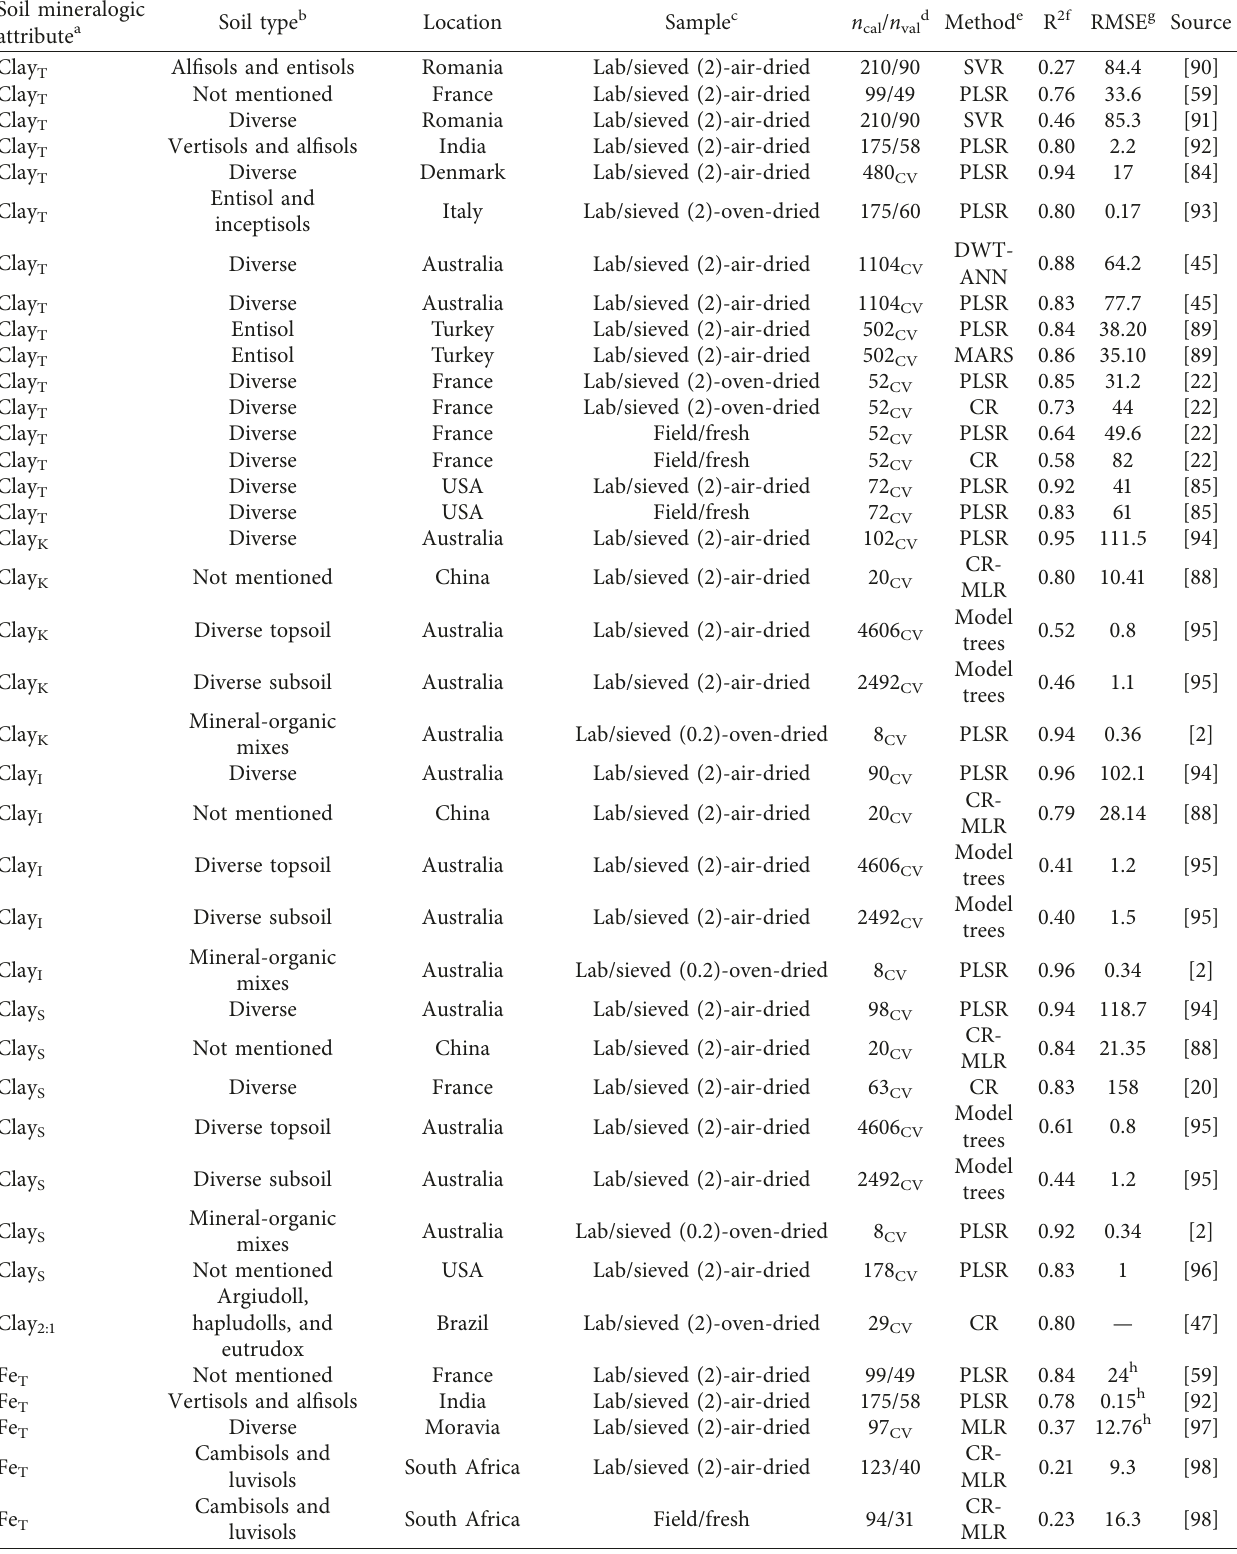
Table 2: A review of VNIR spectroscopy for the prediction of soil attributes using feature-based and chemometric methods in previous